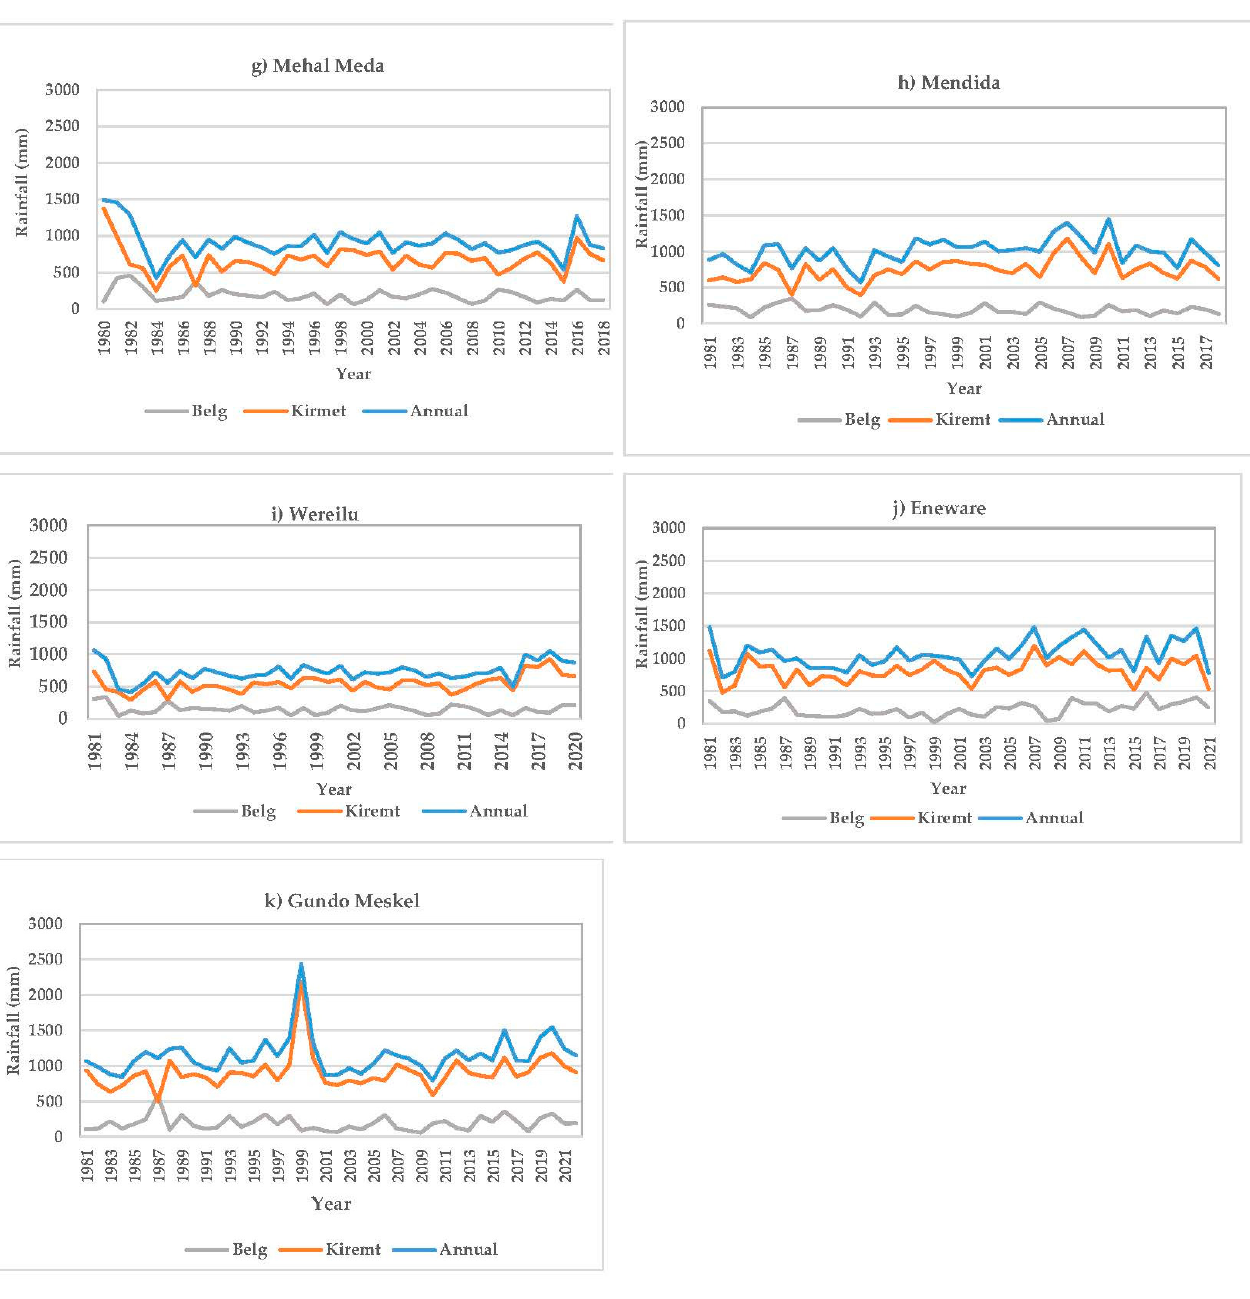
Figure 4. Seasonal and temporal variability of rainfall at: ( a ) Andit tid, ( b ) Debrebrhan, ( c ) Alemketema, ( d ) Fiche, ( e ) Gohatsion, ( f ) Lemi, ( g ) Mehal Meda, ( h ) Mendida, ( i ) Wereilu, ( j ) Eneware, and ( k ) Gundo Meskel stations .